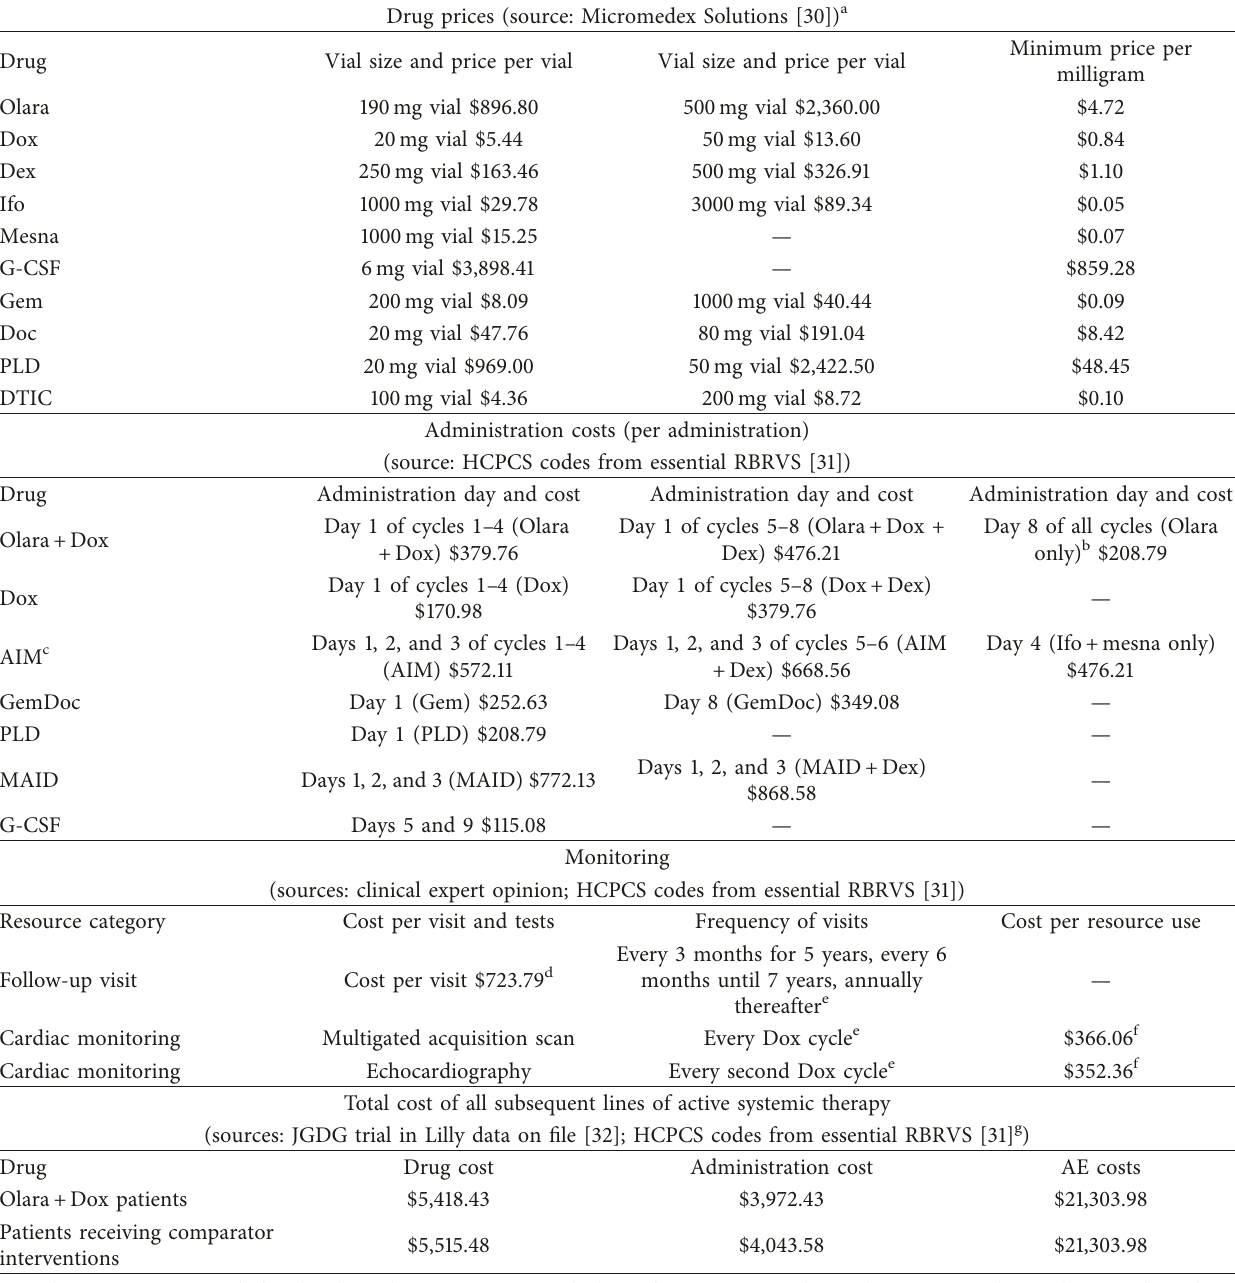
Table 2: Key input